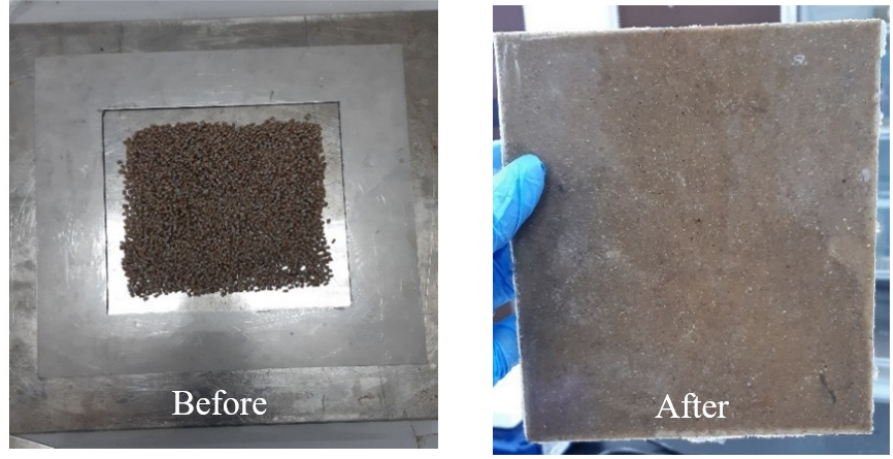
Figure 2. Sample before and after the compression process.